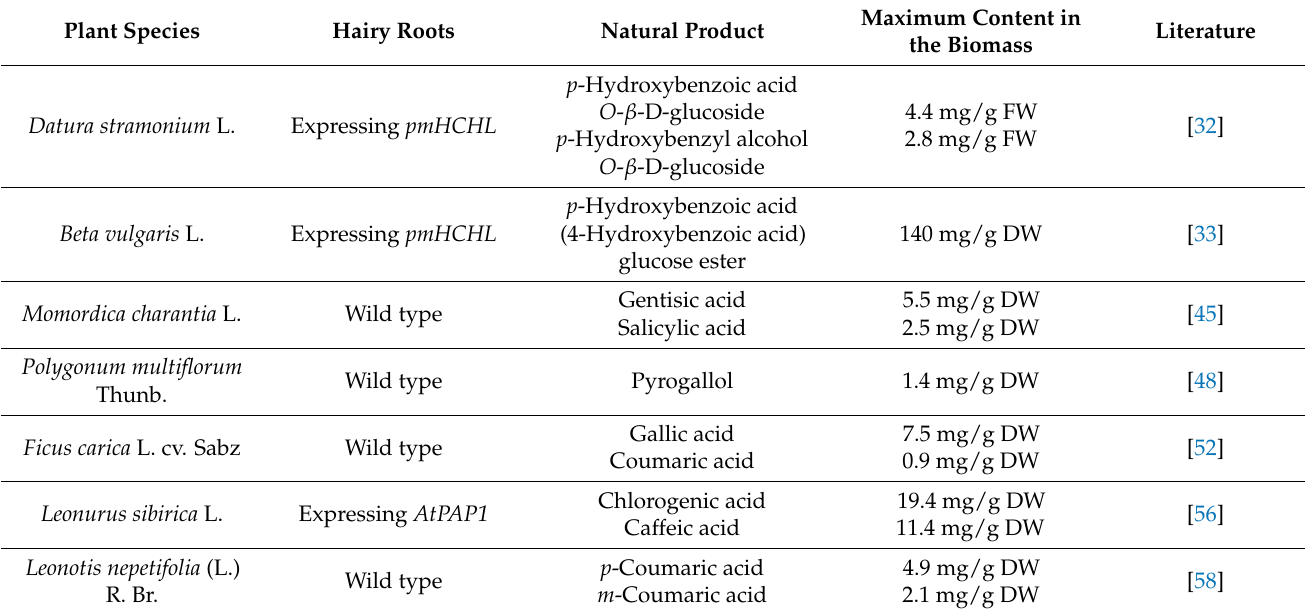
Table 1. Hairy root cultures that produced high yields of simple phenolics and phenolic